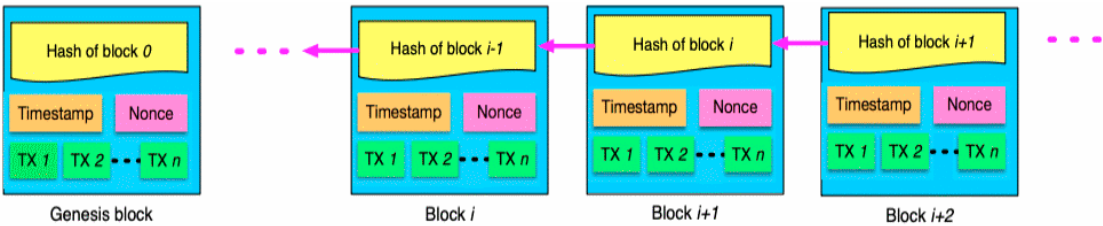
Figure 2. An example of blockchain consisting of a continuous linked block. A block is fundamentally divided into 2 sections, the block body and the block header.